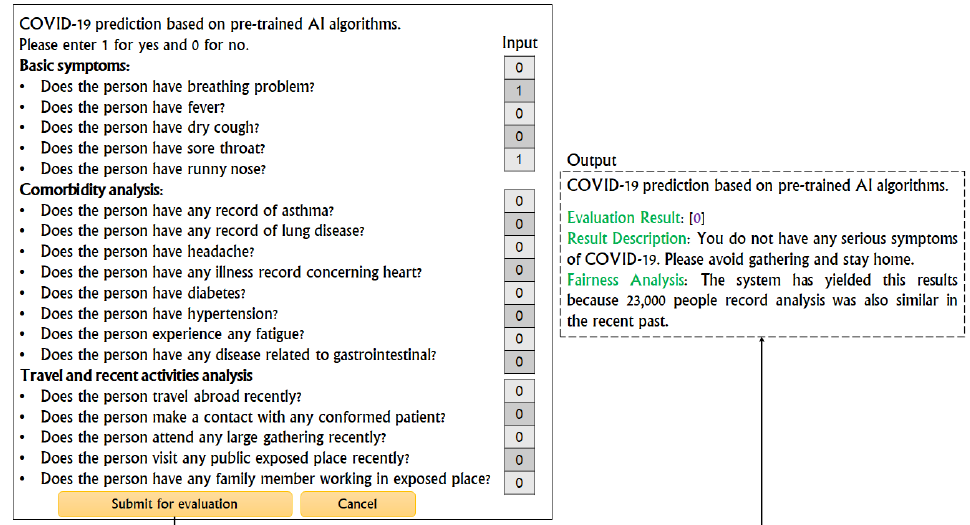
Figure 12. Overview of service that can be used to self-check the possibility of COVID-19 infection.